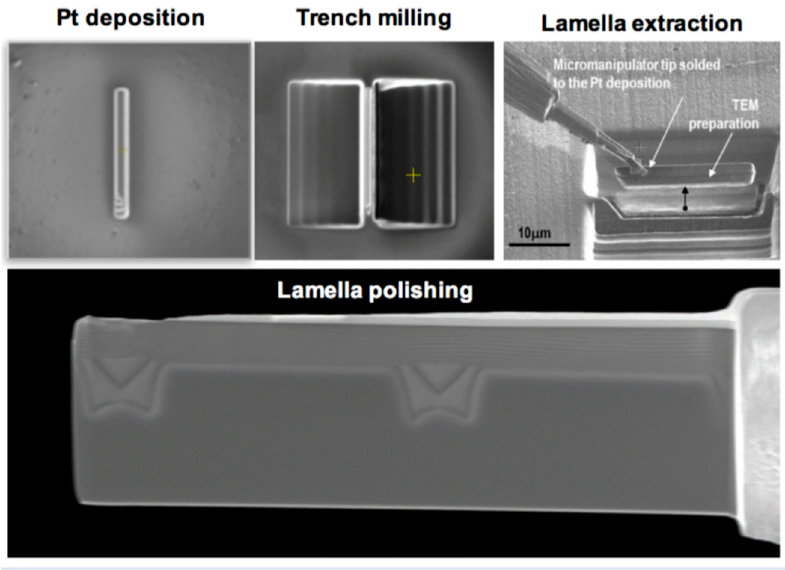
Figure 4. Lift-off methodology for the preparation of TEM lamella in diamond materials. After Pt deposition for surface protection, two parallel trenches are milled at both sides, and, after cutting off and removing using a micromanipulator tip, final polishing is performed.